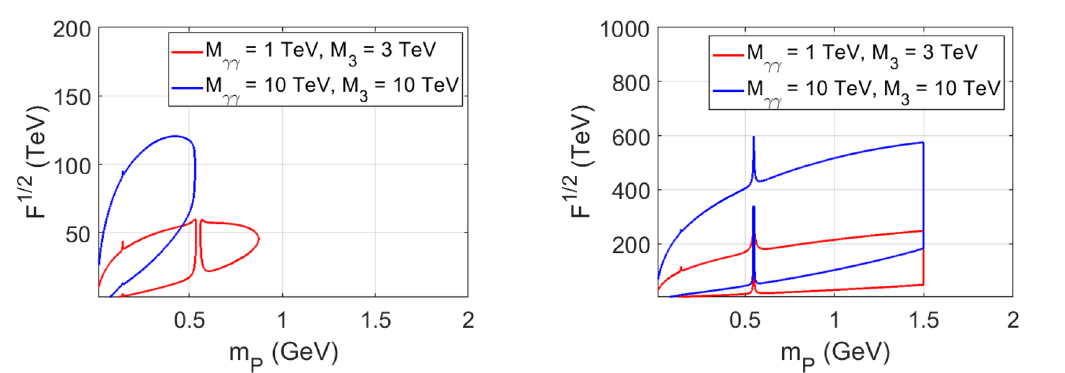
Figure 23 . FASER-I (left plot) and FASER-II (right plot) sensitivities to models with light pseu- doscalar sgoldstino produced in gluon fusion and decaying into a couple of photons. In the regions √ √ where F < M γγ we set M γγ = F and the same for M 3 .